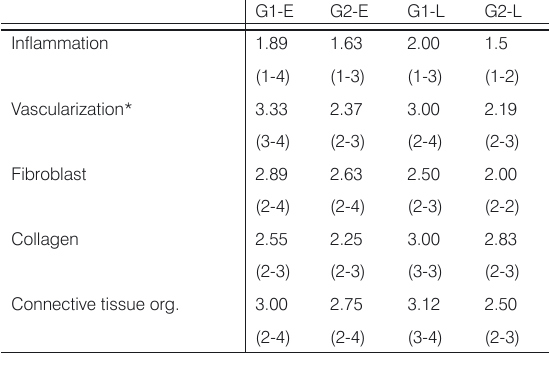
Values in parenthesis display minimum and maximum scores. * G1-E vs. G2-E :